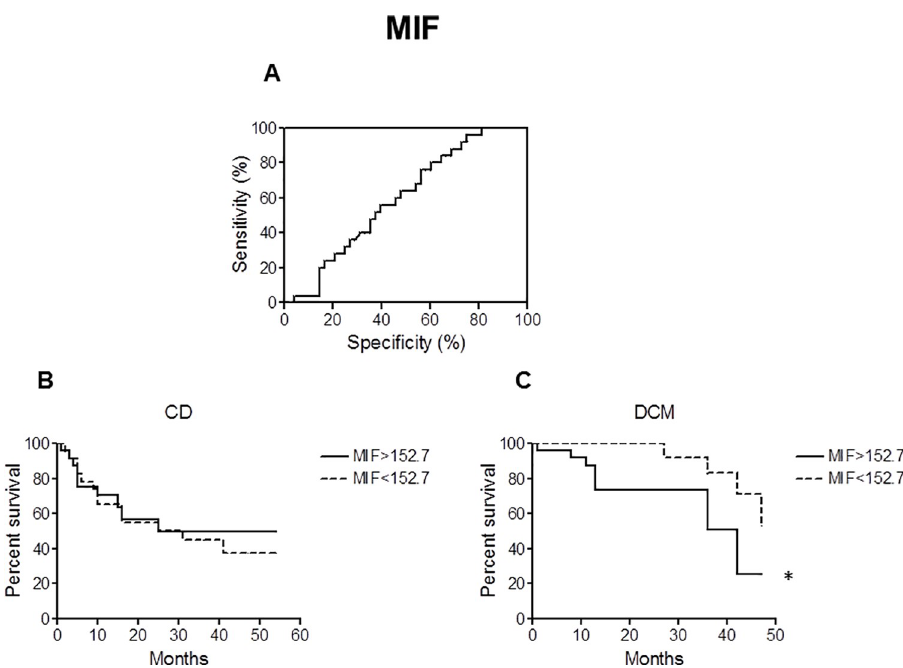
Fig 2. Receiver operating characteristic (ROC) and Kaplan-Meier curves (MIF). A. ROC curve was used to define cut-off value for MIF with best sensitivity and specificity based on CD patients in NYHA classes I-IV (Sensitivity: 64.00%; Specificity: 52.08%). The cut-off value was calculated to be 152.7 pg/mL. B, C. Kaplan-Meier survival curves were generated to compare percent survival in CD (B) and DCM (C) patients with MIF higher or lower than cut-off value (cut-off = 152.7 pg/mL); � p <